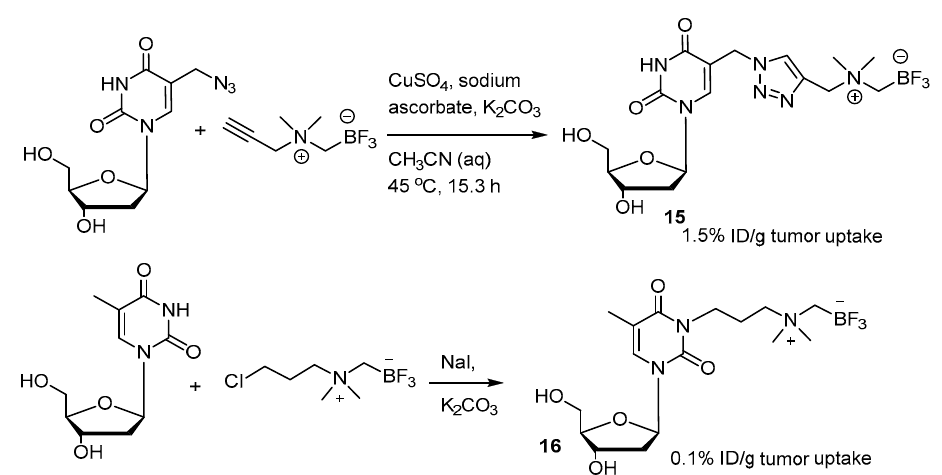
Scheme 8. Nucleoside trifluoroborate 15 formed from 1,3-dipolar cycloaddition compared with